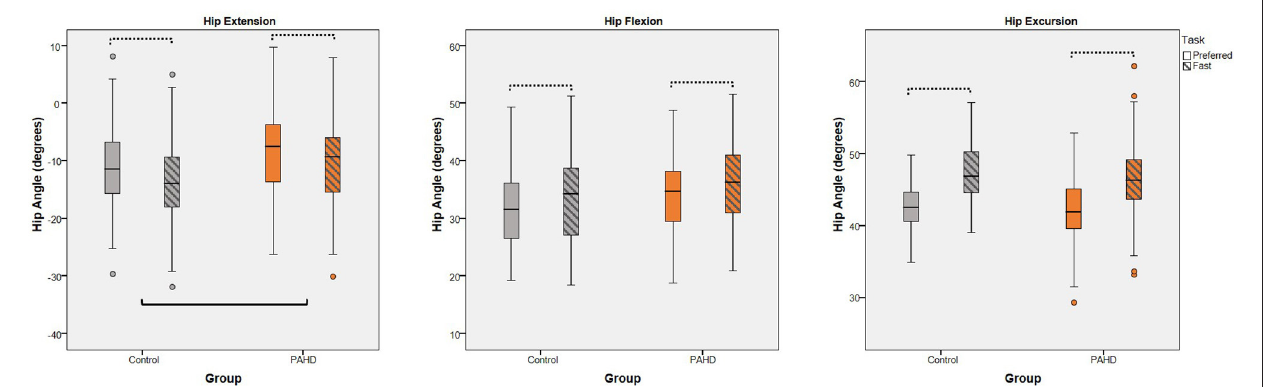
FIGURE 4 | Interaction of Group and Task: Box plots (and outliers) for each dependent variable (peak hip extension, peak hip flexion, and hip excursion) for individuals with pre-arthritic hip disease (PAHD) and healthy individuals without pain (Control). All individuals, independent of group, increase hip angles at the fast speed compared to the preferred speed (dotted bars). The PAHD group had less hip extension than the Control group. No interaction of group and task was noted for any variable. Hip flexion is represented as positive. Solid bar indicates significant group